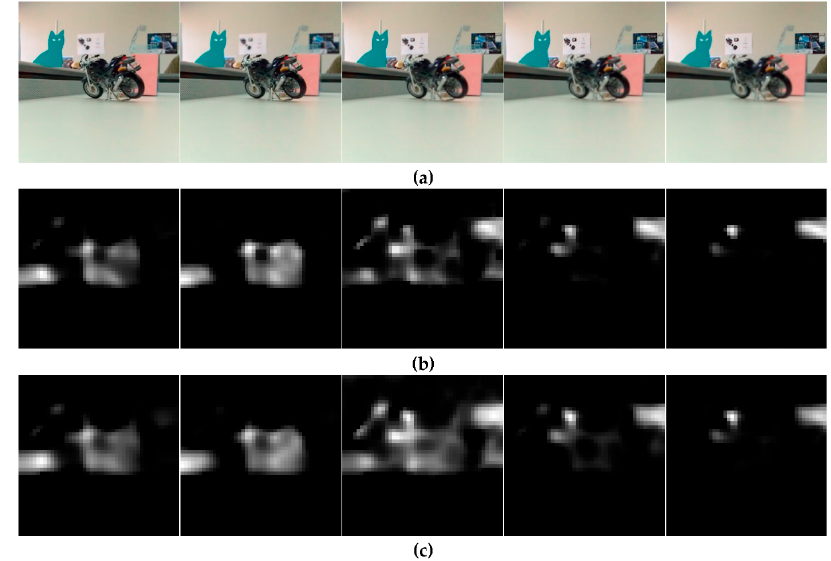
Figure 9. In-focused regions of the different focal stack images using SML and SUML: ‘Bike’ dataset; ( a ) The input images of different focal lengths; ( b ) SML of stack images; and ( c ) SUML of stack images.